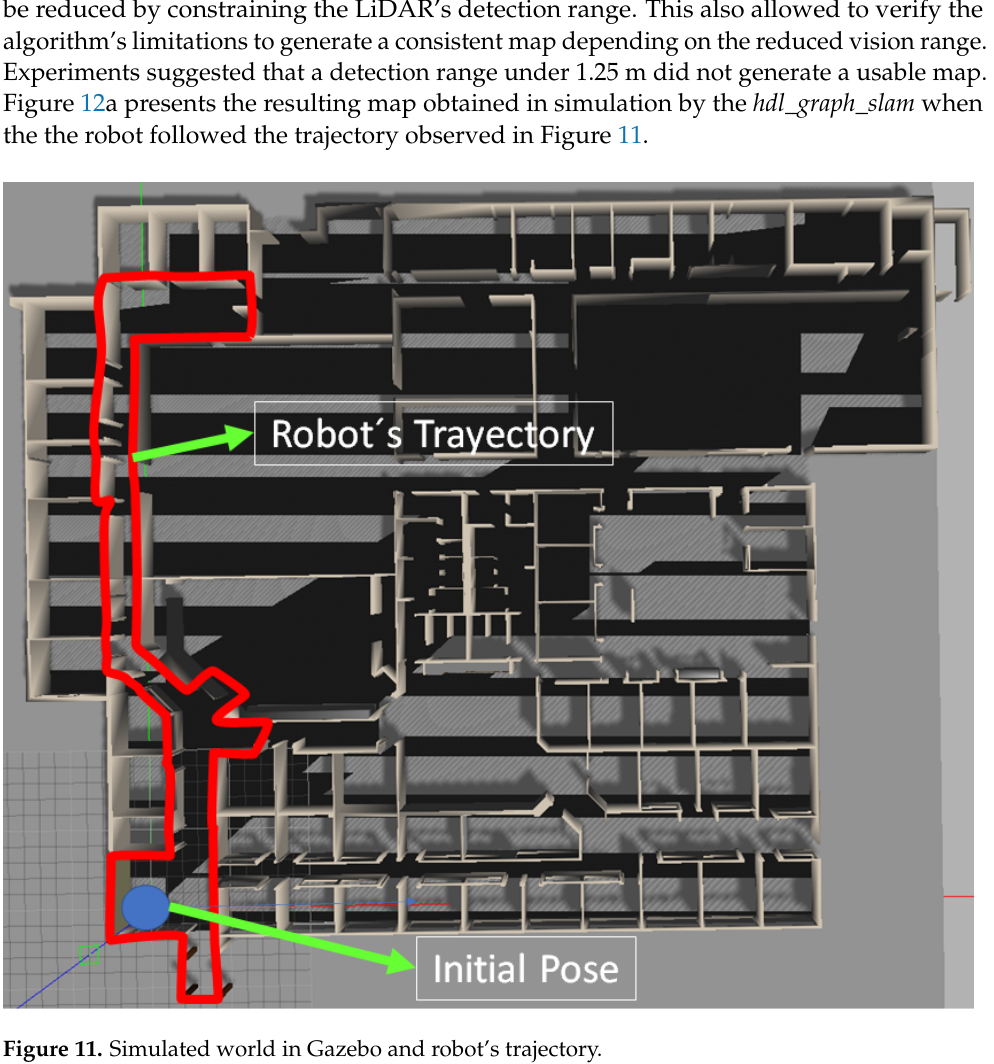
Figure 11. Simulated world in Gazebo and robot’s